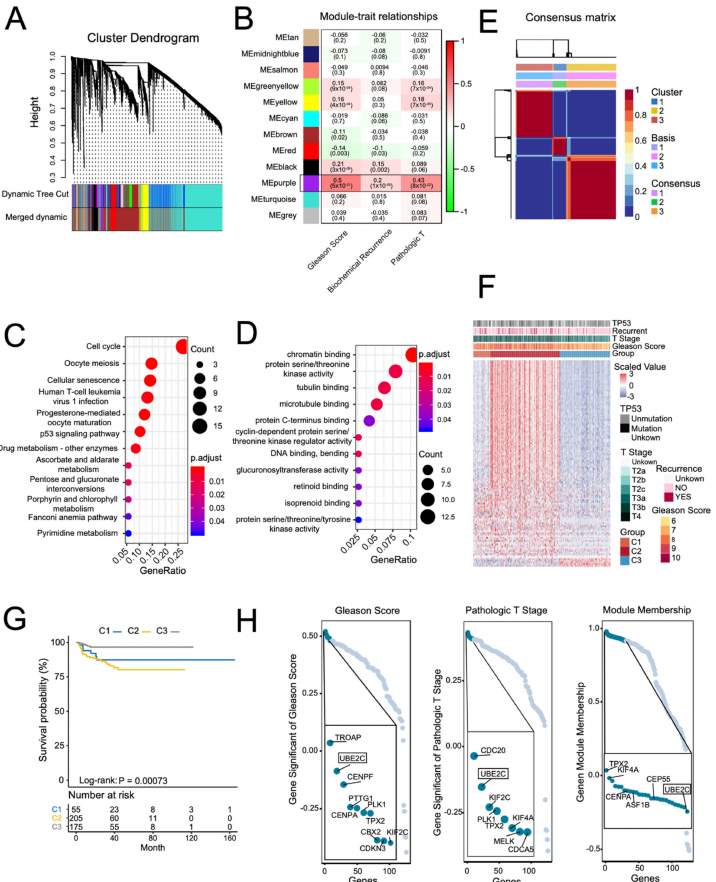
Figure 1. Screening PCa-progress-related hub genes in the TCGA PCa cohort using weighted gene co-expression network analysis (WGCNA). ( A ) A dendrogram generated using the WGCNA, which identified 17 distinct gene modules. Each module is assigned a unique color. ( B ) Pearson’s correlation coefficient (PCC) matrix between module eigengenes (M.E.s) and clinical traits. The PCC values range from − 1 to 1 depending on the strength of the relationship. A positive value indicates that the genes within a particular co-expression module increase as the clinical trait increases, whereas the opposite is true if the PCC is negative. Each PCC value is accompanied by the corresponding p -value in brackets. C and D: representative enriched G.O. functions ( C ) and KEGG pathways ( D ) of genes in the purple module. ( E ) Non-negative matrix factorization (NMF) using the genes in the purple module divided the TCGA PCa cohort into three distinct clusters. ( F ) Heatmap of the expression of genes in the purple module, clinical features, and TP53 mutation across the three NMF clusters. ( G ) Kaplan–Meier curve of PSA recurrence-free survival (RFS) rates in different NMF clusters. H: representative genes with high gene significance of Gleason score, pathologic T, and module membership in the purple module. ( H ) Rank for genes in purple module based on gene significance for Gleason Score (Left) and pathologic T stage (Middle), and gene module membership